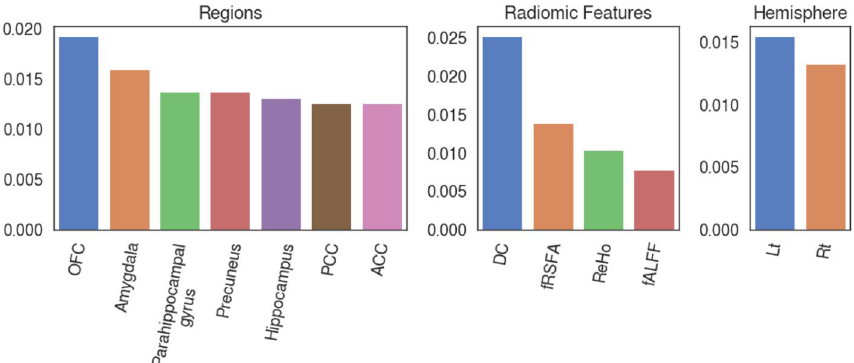
Figure 5. Sum of absolute SHapley Additive exPlanation (SHAP) feature importance for each region, radiomic feature, and the two hemispheres. OFC orbitofrontal cortex, PCC posterior cingulate cortex, ACC anterior cingulate cortex, DC degree centrality, fRSFA fractional resting-state physiological fluctuation amplitude, ReHo regional homogeneity, fALFF fractional amplitude of low-frequency fluctuation, Rt right, Lt